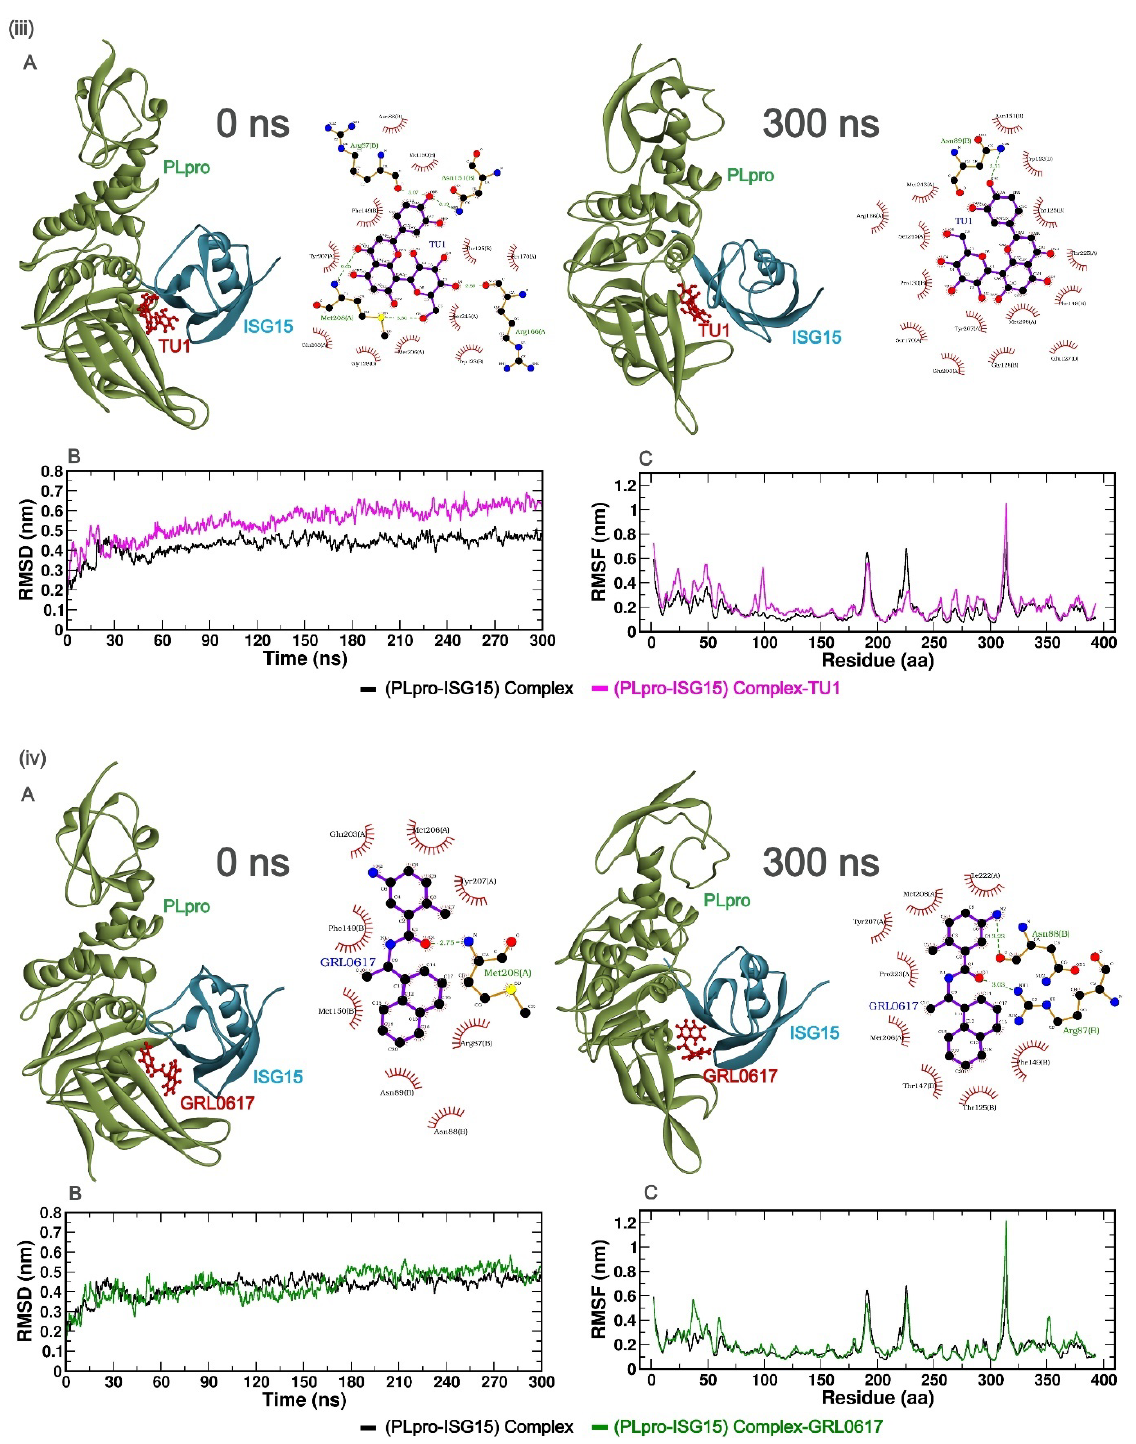
Figure 2. ( i – iv ( A ))—The best poses of the phytochemicals (AG1 (red), GU1 (blue), TU1 (magenta), and GRL0617 (green)) binding to the interface of (PLpro-ISG15)-complex at 0 ns (left) and 300 ns (right) during molecular dynamics (MD) simulation. Each inset shows the detailed interactions of each drug candidate docked to the ISG15 interacting site of the PLpro, indicating the amino acids involved in the interaction and the type of interaction (hydrogen bonds, hydrophilic interactions, salt bridges, Π -stacking, etc.). ( i – iv ( B )) show RMSD, and ( i – iv ( C )) show RMSF values over 300 ns simulation for different complexes with phytochemicals.